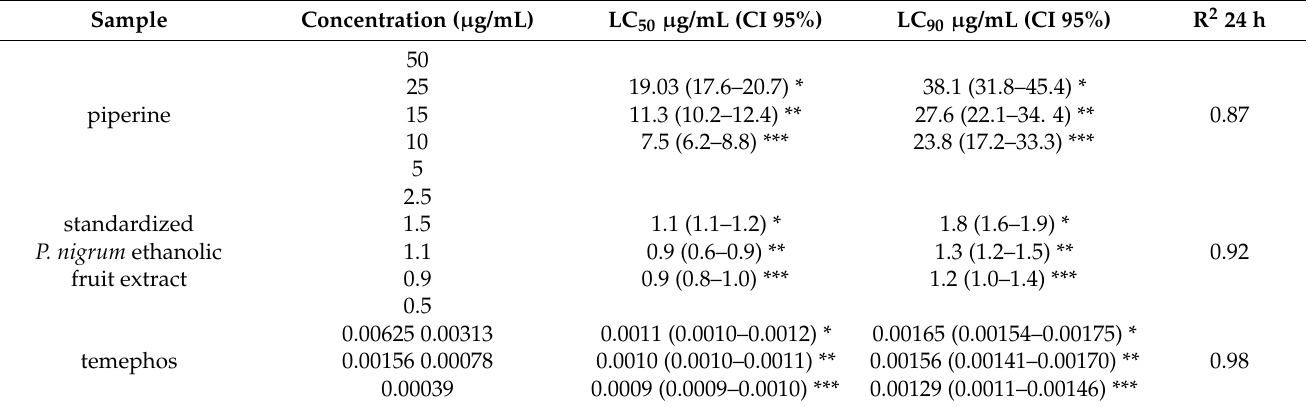
Table 3. Larvicidalactivityofpiperineandstandardized P.nigrum ethanolicfruitextractagainst Ae. aegypti